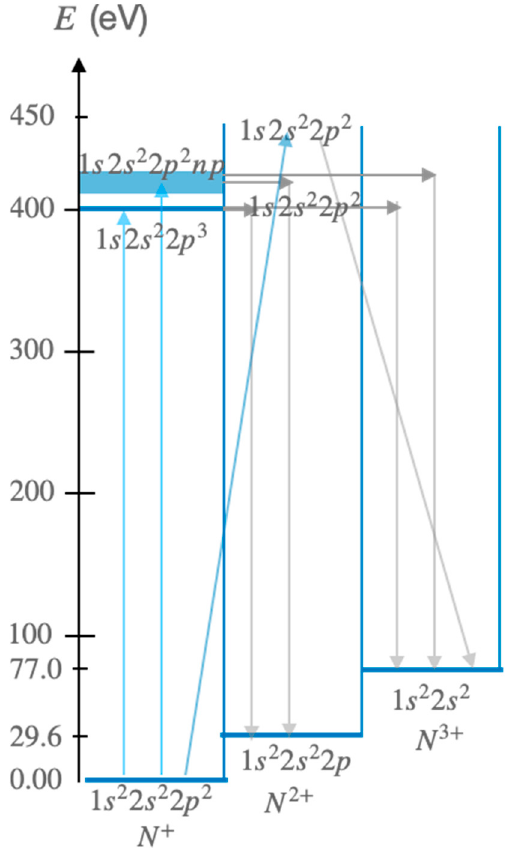
Figure 1. Schematic energy level diagram showing the main excitation and decay processes (upward and downward arrows, respectively) involved in this work. The initial photon absorption process excites a 1 s electron from the various states of the 1𝑠 (cid:2870) 2𝑠 (cid:2870) 2𝑝 (cid:2870) and 1𝑠 (cid:2870) 2𝑠2𝑝 (cid:2871) configurations to the 1𝑠2𝑠 (cid:2870) 2𝑝 (cid:2871) (near 400 eV) and 1𝑠2𝑠 (cid:2870) 2𝑝 (cid:2870) 𝑛𝑝 or 1𝑠2𝑠2𝑝 (cid:2871) 𝑛𝑝 (between 418 eV and 440 eV) states. The direct ionization process to 1𝑠2𝑠 (cid:2870) 2𝑝 (cid:2870) in N 2+ followed by Auger decay to 1𝑠 (cid:2870) 2𝑠 (cid:2870) in N 3+ is also shown.